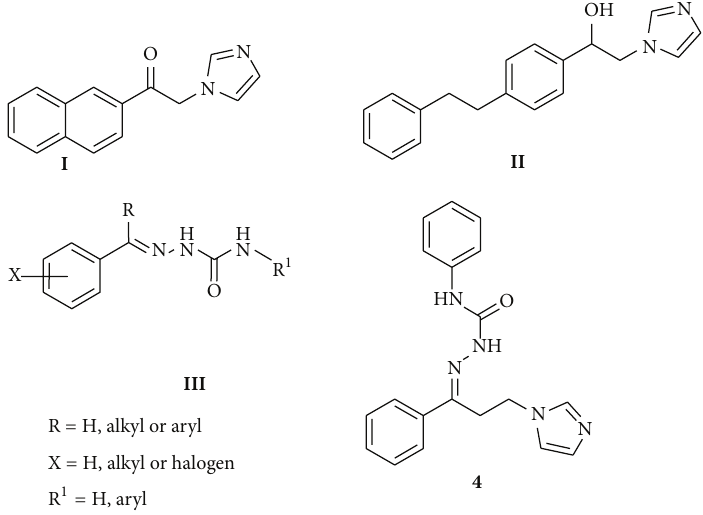
Figure 1: Chemical structures of nafimidone ( I ), denzimol ( II ), arylsemicarbazones III , and the target compound 4